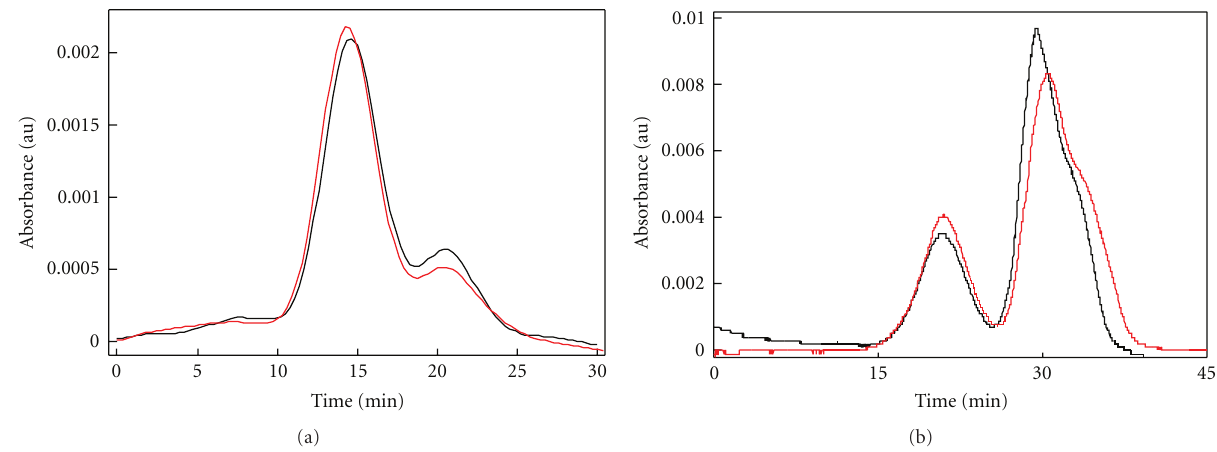
Figure 4: Anesthetic agents promote albumin dimerization. HSA[A] and BSA[B] were treated with (red) and without (black) agent (sevoflurane [A] and isoflurane [B]) prior to size exclusion chromatography and quantitation of the peaks. Tracings in (a) are smoothed curves that represent averages from four independent experiments. Tracings in (b) are from a representative experiment. Column size and flow rates di ff ered slightly between (a) and (b) with gamma globulin (158kDa) eluting at 13.1 and 19.2 minutes,